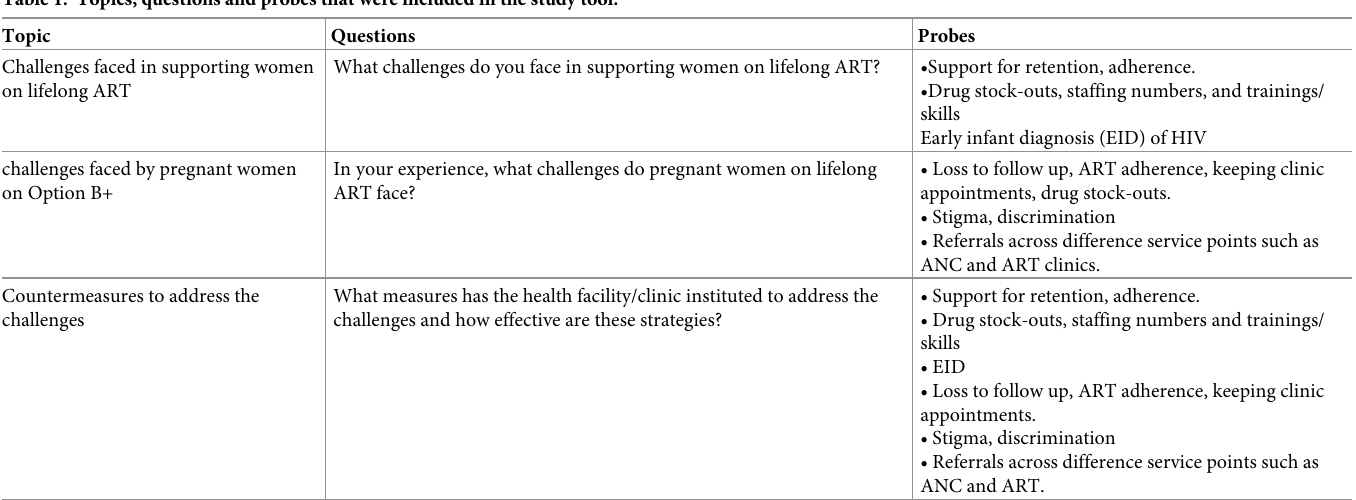
Table 1. Topics, questions and probes that were included in the study